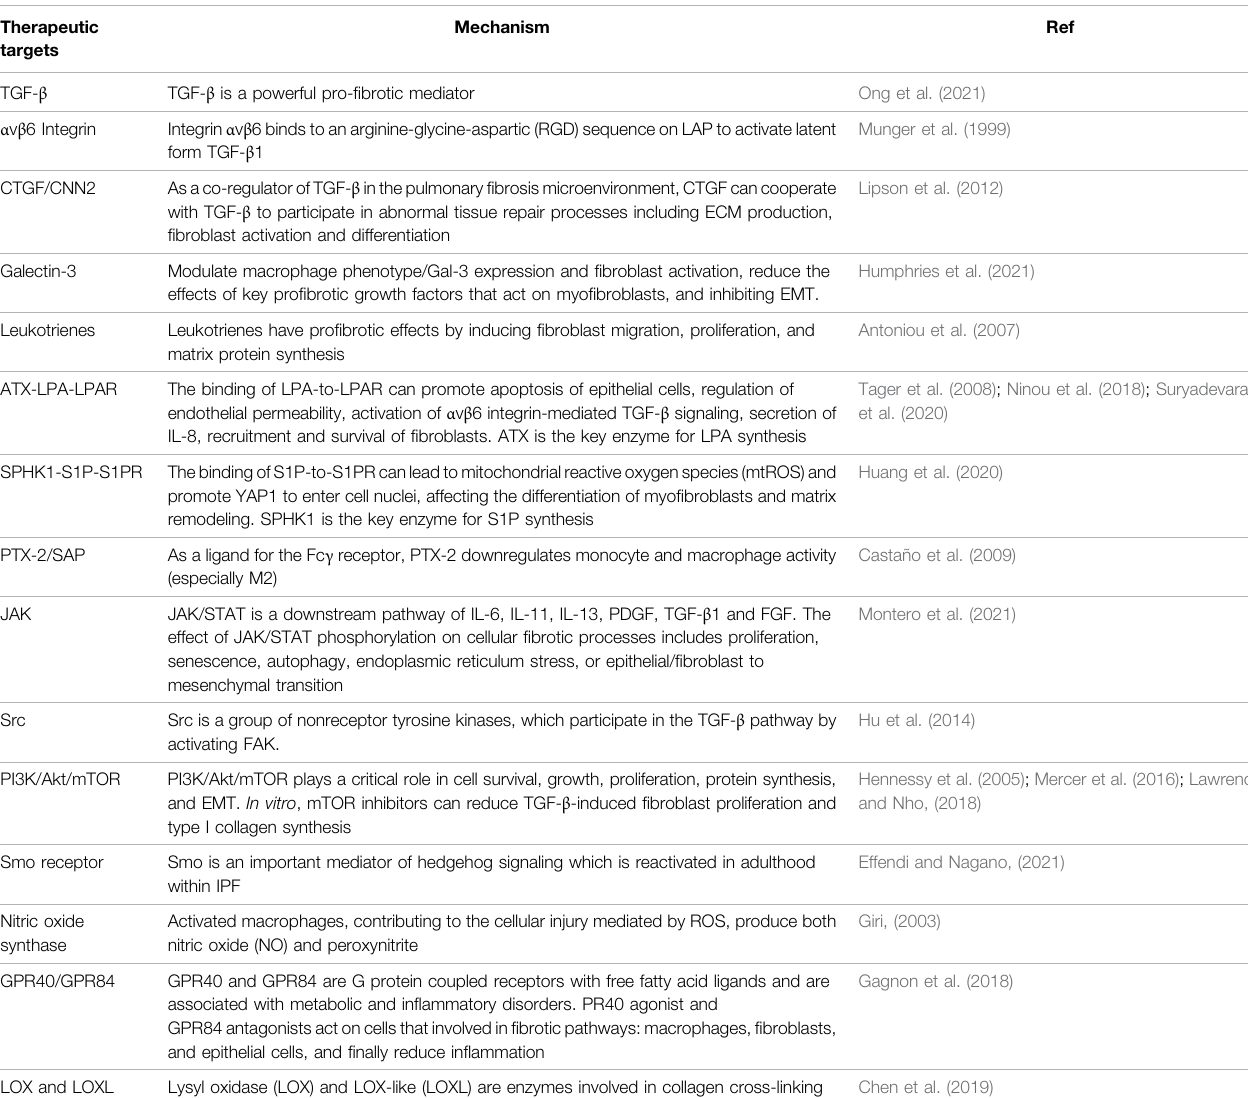
TABLE 4 | Summary of emerging therapeutic targets for IPF in drug discovery. Therapeutic